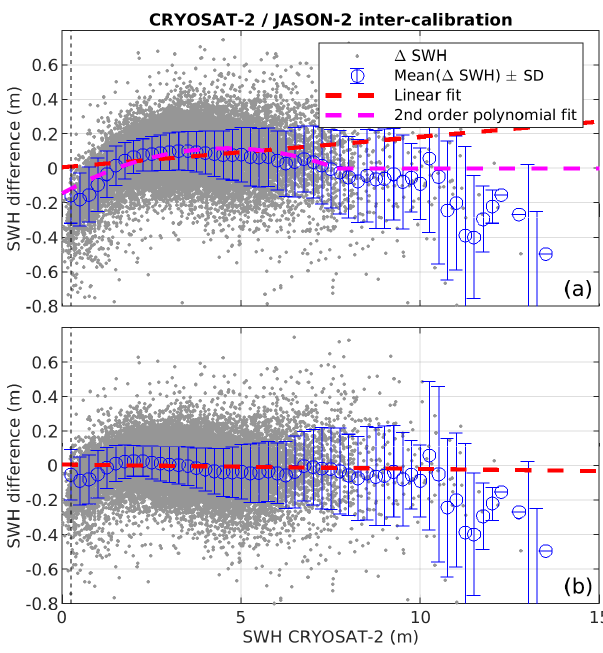
Figure 5. Residual of SARAL SWH − JASON-2 SWH as a func- tion of SARAL SWH before (a) and after (b) calibration. The dashed red line is a linear fit through the data.